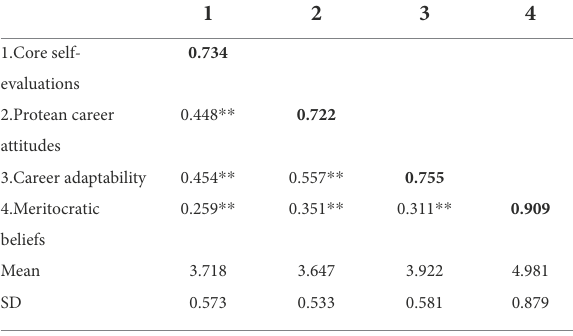
TABLE 2 Descriptive statistics and correlations of study variables.